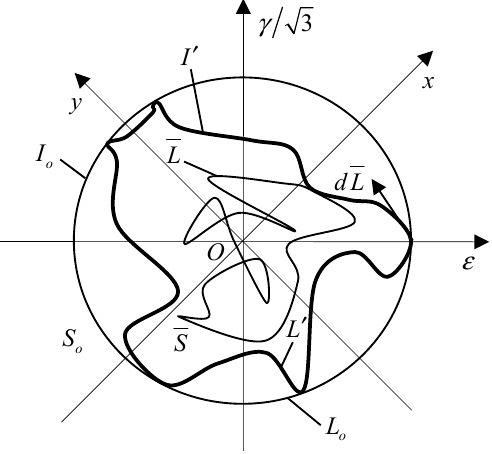
Figure 15. Random strain path and its envelope path.